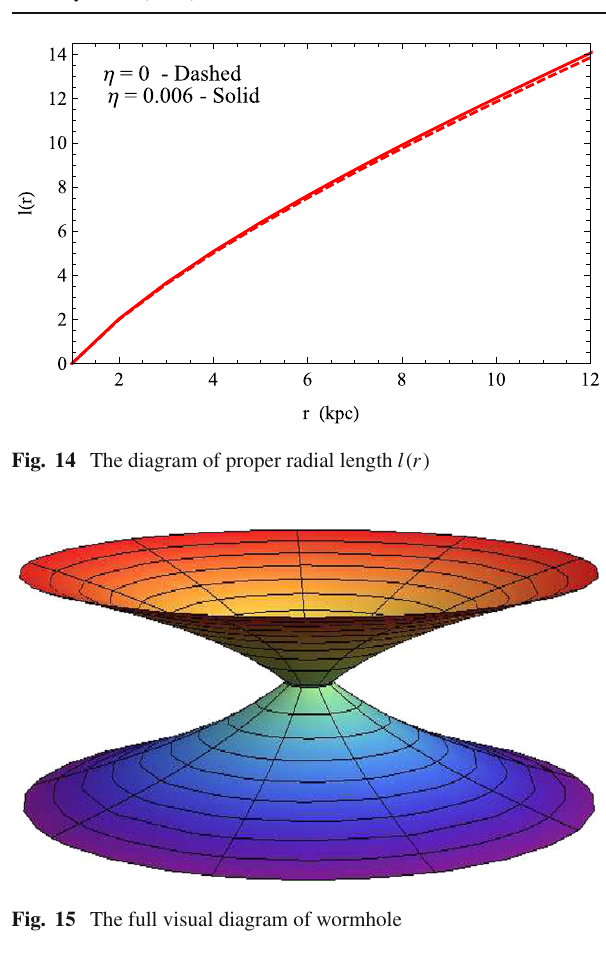
+ where r is an arbitrary nearest distance of the throat from th right hand